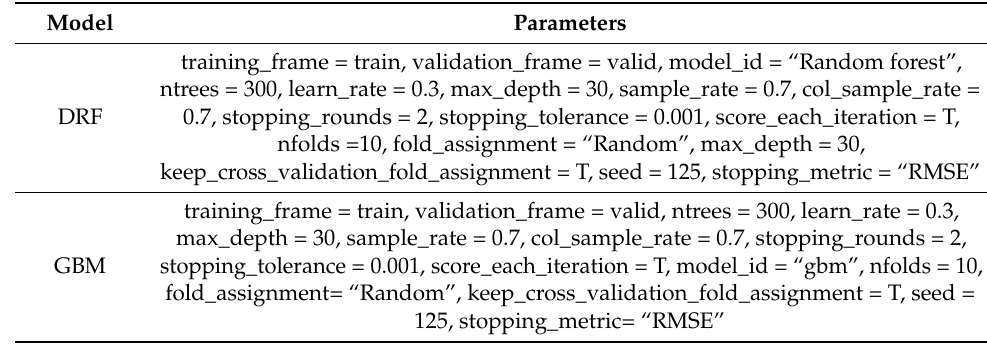
Table A1. The detailed list of parameters with their values used for DRF and GBM